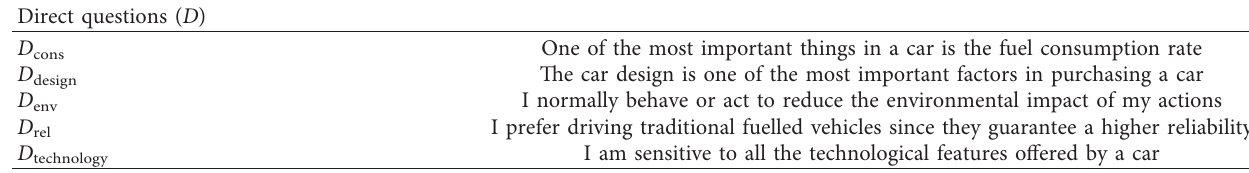
Table 2: Overview of direct questions submitted to the respondents.